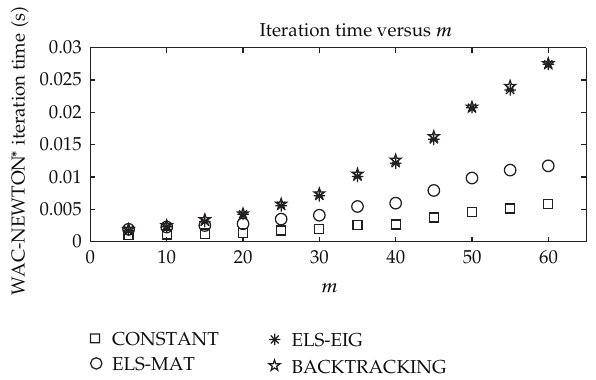
Figure 13: Time required to perform an iteration of WAC-NEWTON ∗